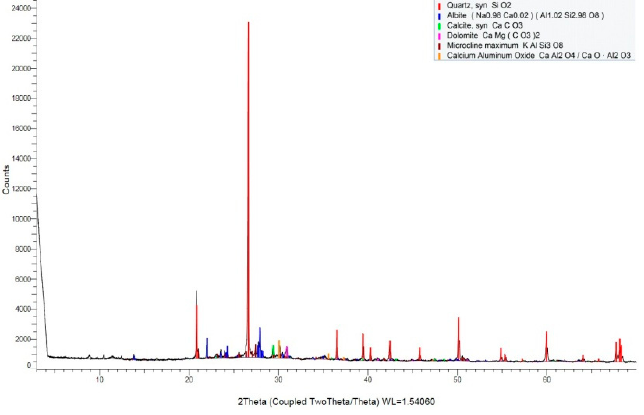
Figure 8. X-ray diffraction pattern of the precipitate.